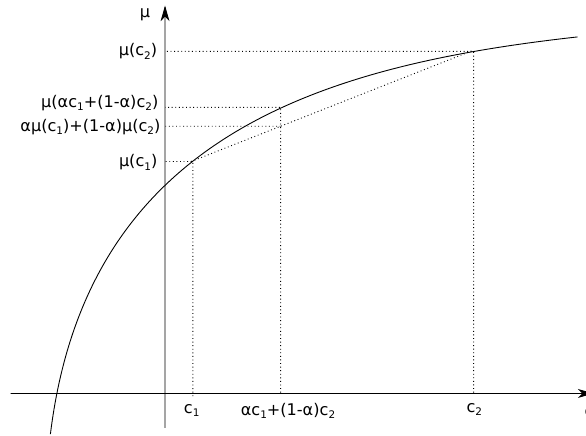
Figure 1. A schematic representation of the CARA utility func- tion for risk-averse individuals. Here, only two states of the world are assumed. The state c 1 is realised with probability α and c 2 is realised with complementary probability. Since µ is concave, we see that the expected utility U = αµ(c 1 ) + ( 1 − α)µ(c 2 ) is smaller than the utility of the expected value µ(αc 1 + ( 1 − α)c 2 ) . In other words, the individual would prefer to receive the certain amount αc 1 + ( 1 − α)c 2 than to receive a lottery which pays c 1 with prob- ability α and c 2 with probability 1 − α . Equivalently, the individual would be willing to pay up to C > 0 to remove the risk associated with this lottery, where C is such that µ(αc 1 + ( 1 − α)c 2 − C) = αµ(c 1 ) + ( 1 − α)µ(c 2 ) .